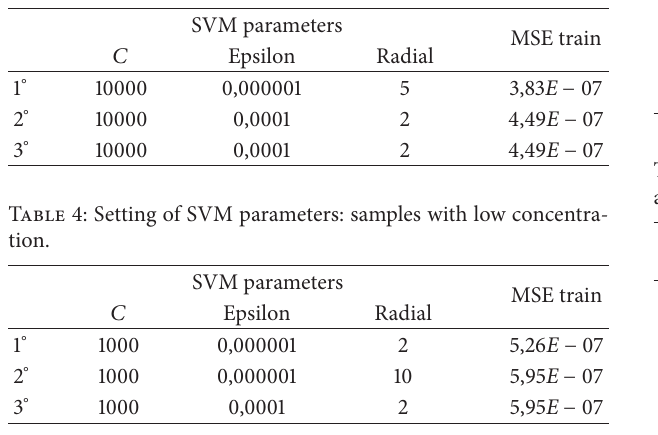
Table 3: Setting of SVM parameters: samples with high concentra- tion.